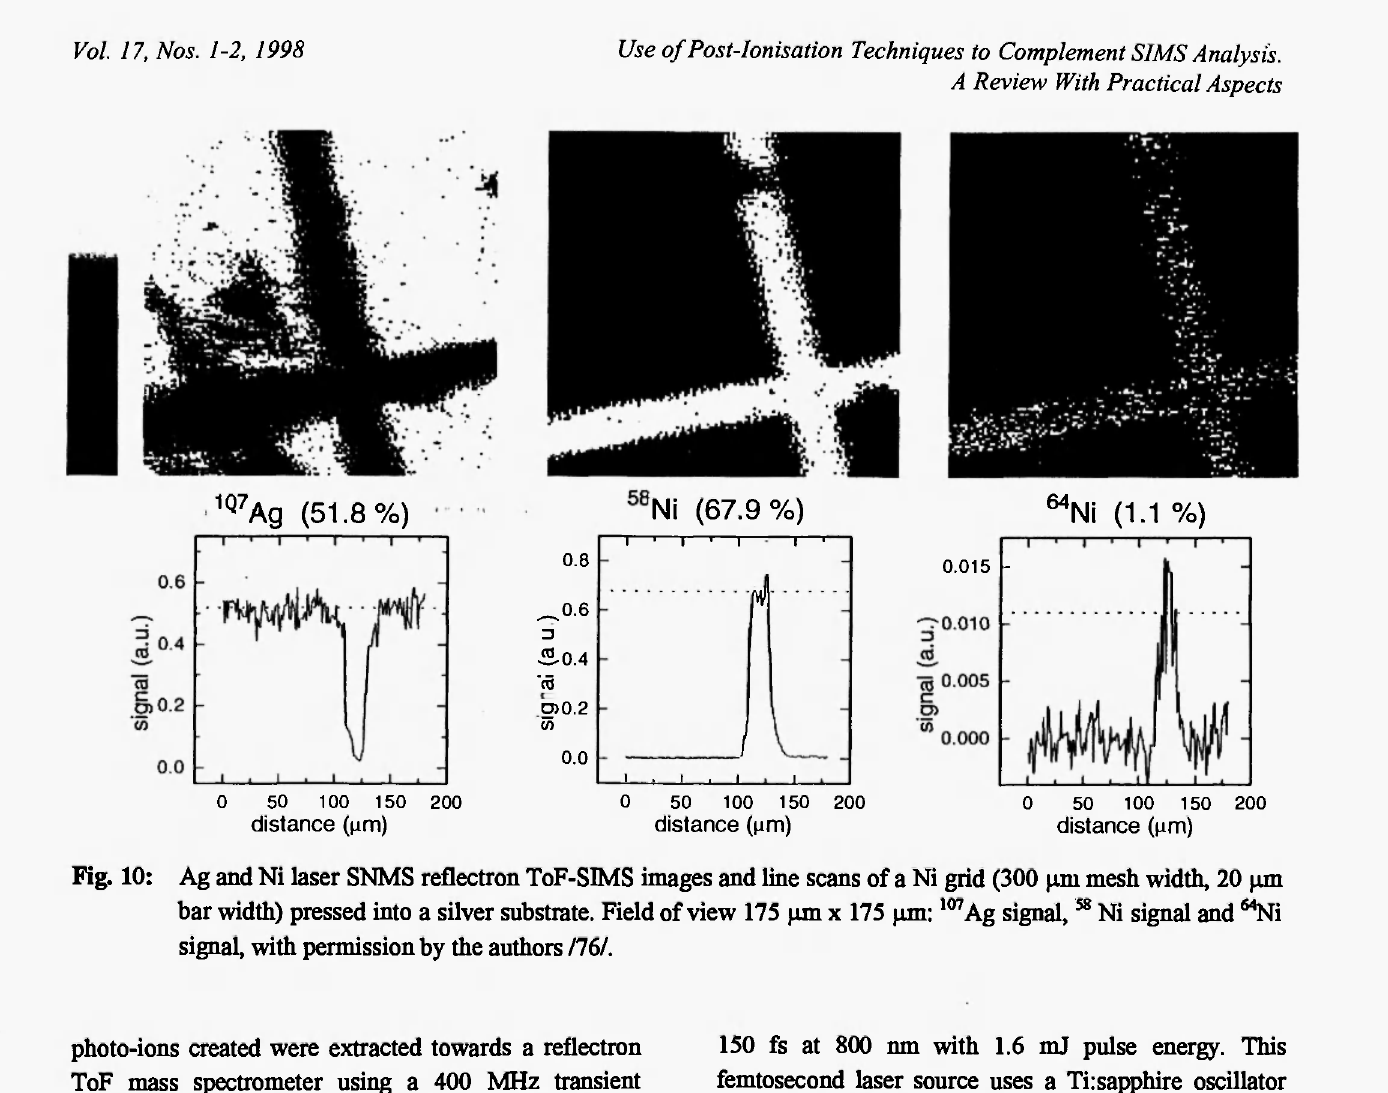
Fig. 10: Ag and Ni laser SNMS reflectron ToF-SIMS images and line scans of a Ni grid (300 μηι mesh width, 20 μιη bar width) pressed into a silver substrate. Field of view 175 μπι χ 175 μιη: 107 Ag signal, 58 Ni signal and "Ni signal, with permission by the authors